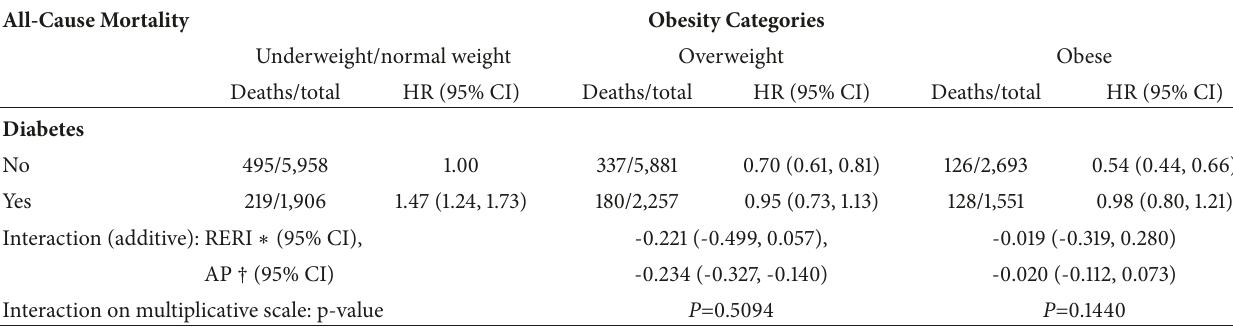
Table 3: Adjusted HRs (95% CIs) for all-cause mortality following an ischemic stroke in relation to categorical indicators of BMI and diabetes. All-Cause Mortality Obesity Categories Underweight/normal weight Overweight